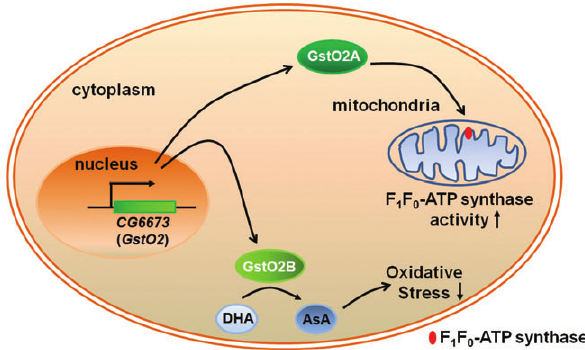
Figure 3 The proposed model for the different functions of Dros- ophila GSTOs.